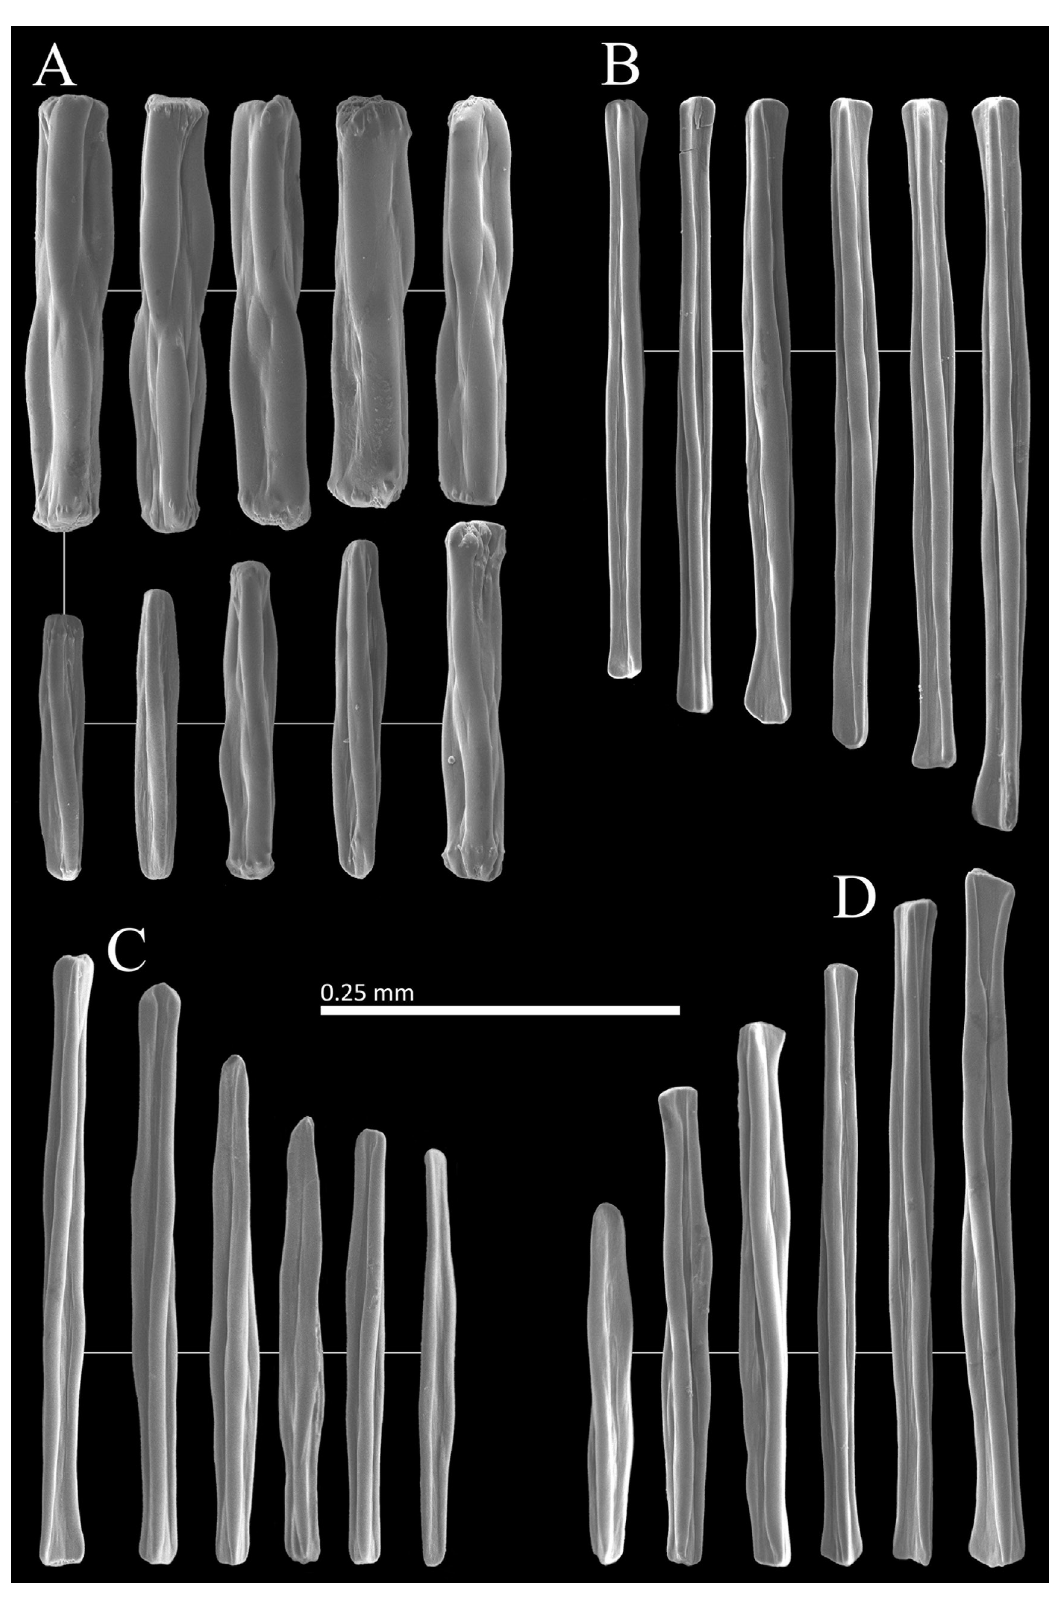
Fig. 10. Gyrophyllum hirondellei Studer, 1891, BECA (OPEN-660). SEM photographs of sclerites. A . Tentacle. B . Polyp leaf, siphonozooids area. C . Calycular pointed processes. D . Rachis